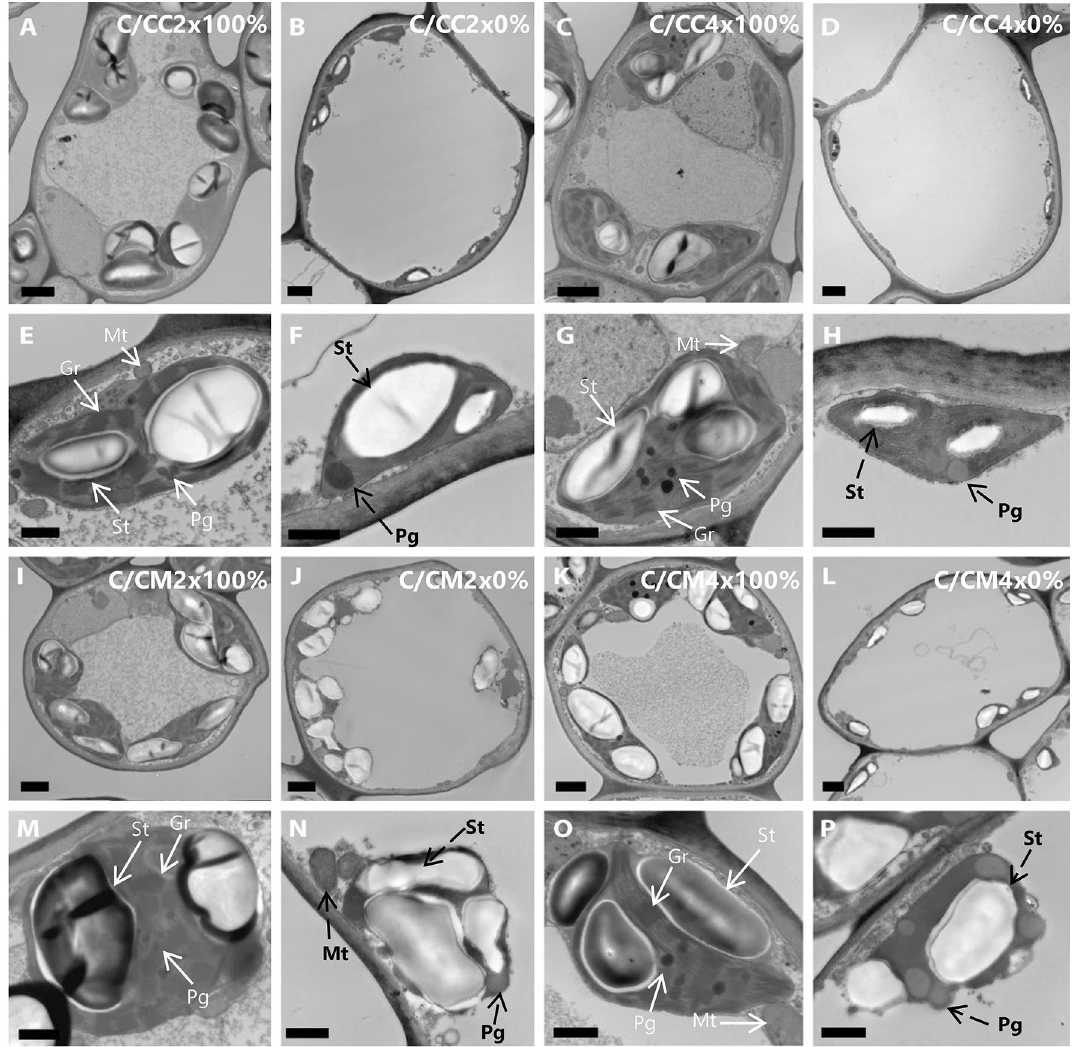
Figure 5. Transmission electron micrographs of spongy mesophyll cells of leaves of common clementine scion grafted onto different rootstocks. (( A,B,C,D,I,J,K,L ); scale bar: 5 µm) Spongy mesophyll cells and (( E,F,G,H,M,N,O,P ); scale bar: 1 µm) their respective chloroplasts in leaves of common clementine scion grafted onto diploid (C/CC2x) and doubled diploid (C/CC4x) Carrizo citrange and diploid (C/CM2x) and doubled diploid (C/CM4x) Citrumelo 4475 rootstocks grown in nutrient reference solution (100%). Scale bars for spongy mesophyll cells (5 µm) and their respective chloroplasts in leaves (1 µm) are indicated at the bottom left for each image. The significant values between rootstock ploidy level of scion/rootstock combinations and treatment are shown in bold and black with a black dotted arrow. St starch, Pg plastoglobuli, Mt mitochondria, Gr